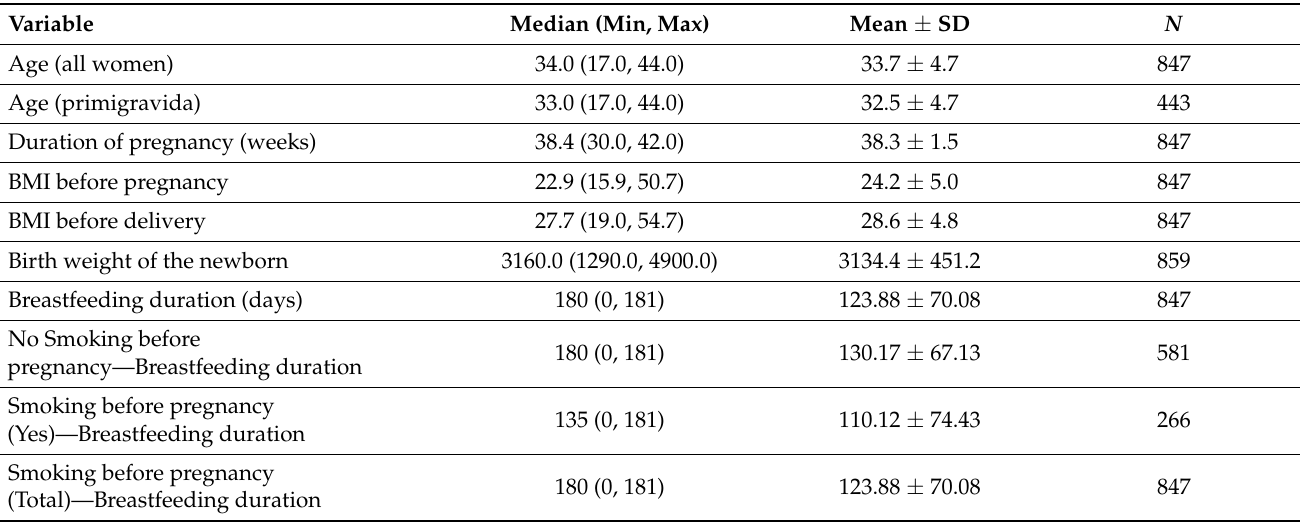
Table 2. Maternal baseline sociodemographic characteristics and history related to pregnancy and birth (quantitative